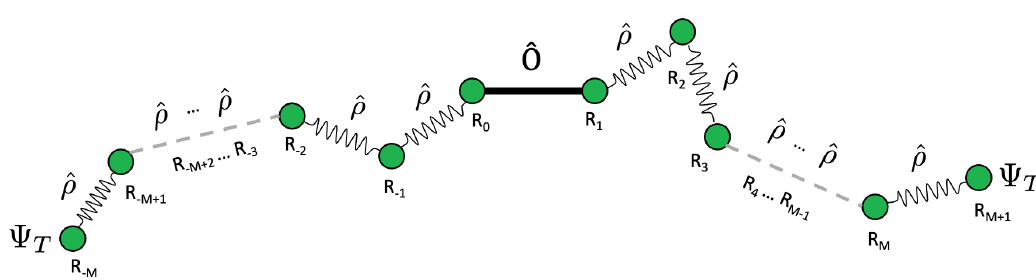
Figure 1: Visual representation of Eq. (13) where the configurations R sented by beads connected through density matrix elements ρ ( R sented by springs. The central beads R represented by a solid bar. The total number of beads in the chain is 2 M + 2, where M is the number of imaginary time compositions used to construct e − τ H . The endpoints R − and R also carry weights associated with the trial wave function Ψ M M + 1